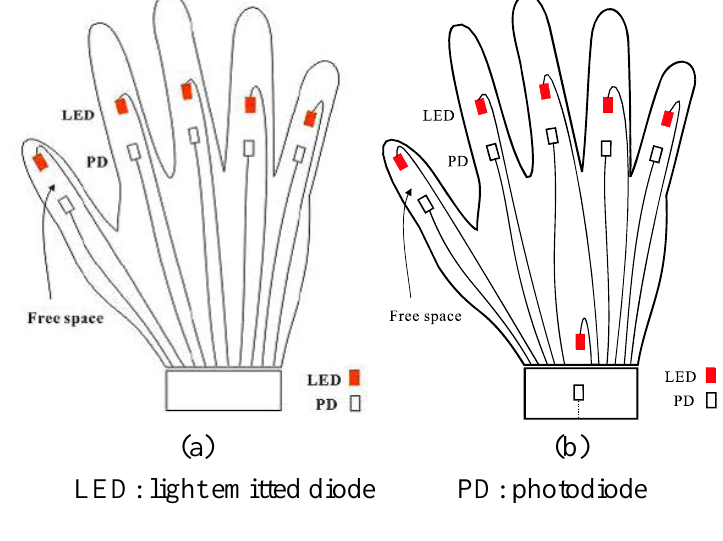
Figure 1. (a) Five sensor data glove design. (b) Six sensor data glove design.